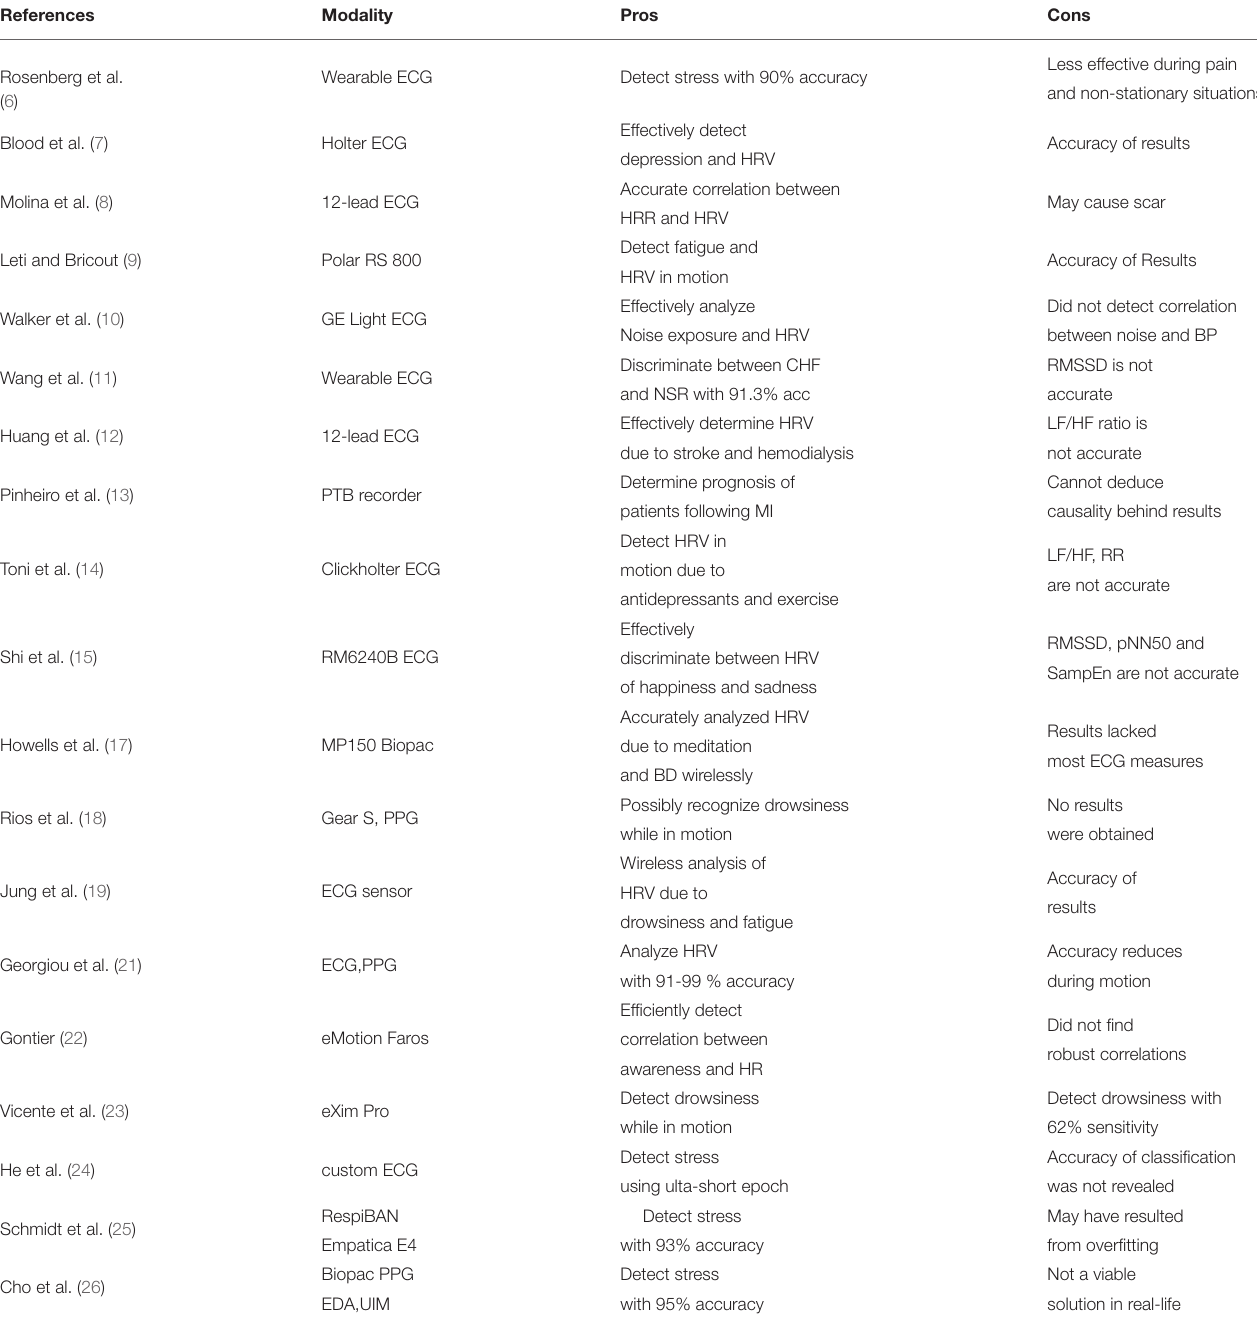
TABLE 2 | Data collection methods, their Pros and